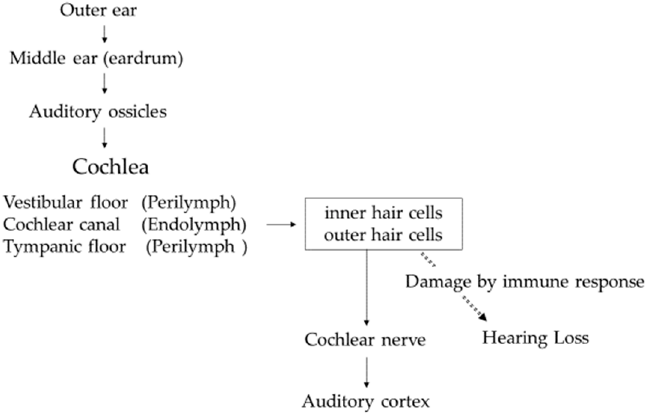
Figure 1. Sound transmission from outer ear to auditory